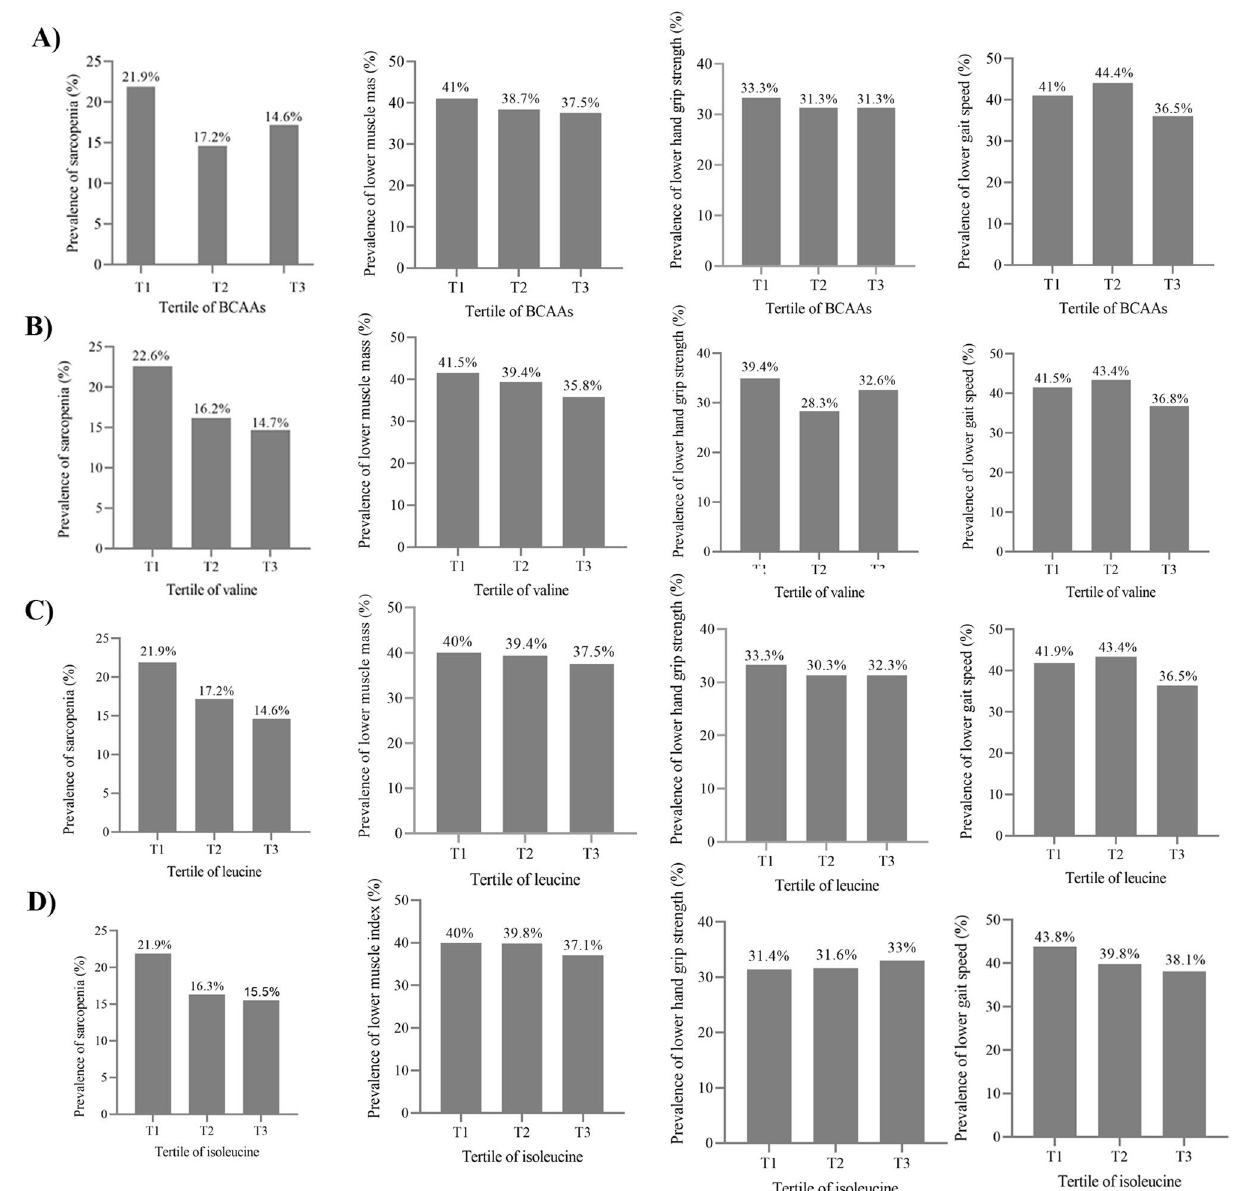
Figure 2. The prevalence of sarcopenia and its components across tertile categories of BCAAS, valine, leucin and isoleucine intakes. A) The prevalence of sarcopenia and its components across tertile categories of BCAAS intake, B) The prevalence of sarcopenia and its components across tertile categories of valine intakes, C) The prevalence of sarcopenia and its components across tertile categories of leucin intake, D) The prevalence of sarcopenia and its components across tertile categories isoleucine